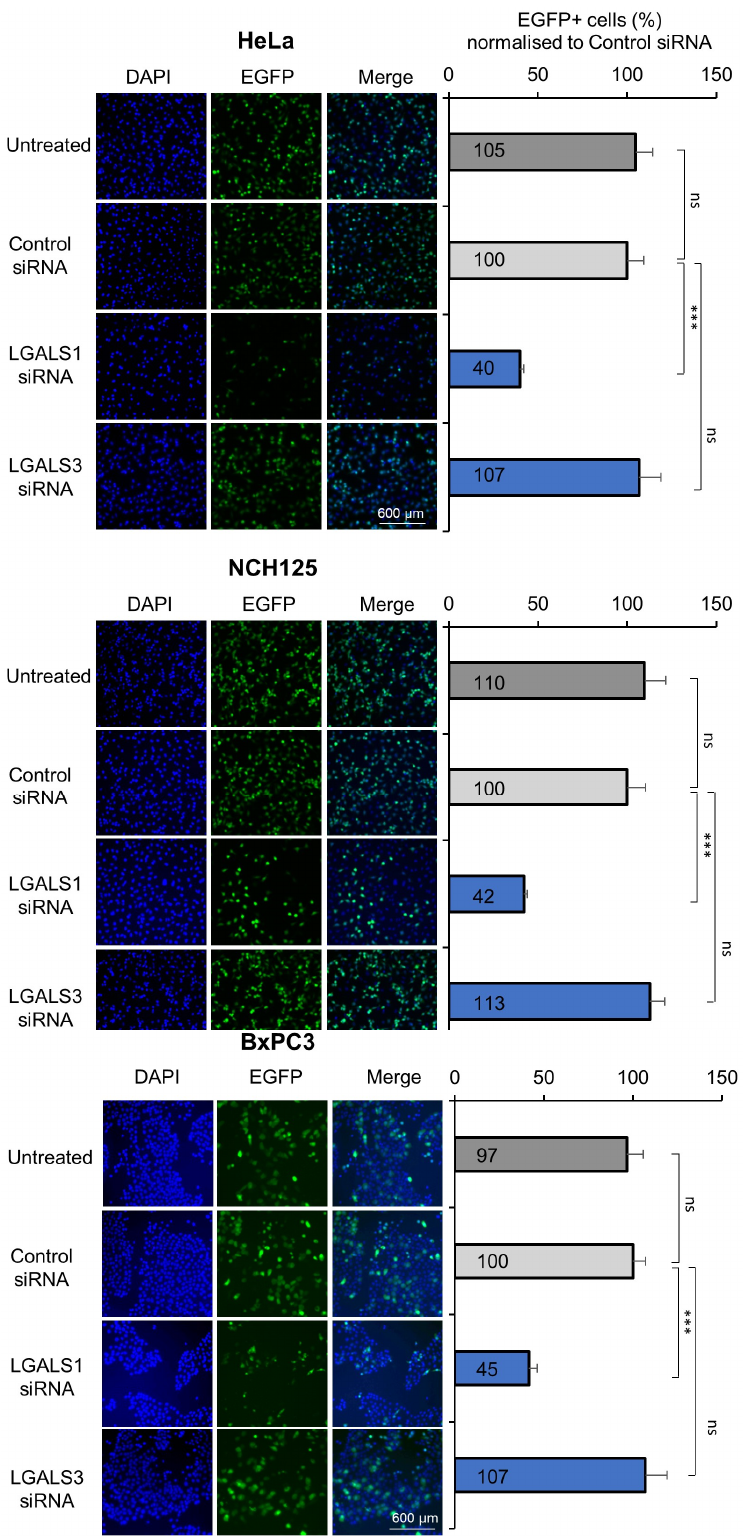
Figure 1. H-1PV transduction is reduced in LGALS1 , but not LGALS3 , knockdown cell lines. HeLa, NCH125 and BxPC3 cells were transfected with siRNAs targeting LGALS1 or LGALS3 or with a scrambled siRNA. At 48 h post-transfection, cells were infected with recH-1PV-EGFP for 4 h and grown for an additional 20 h. Cells were then processed as described in the Materials and